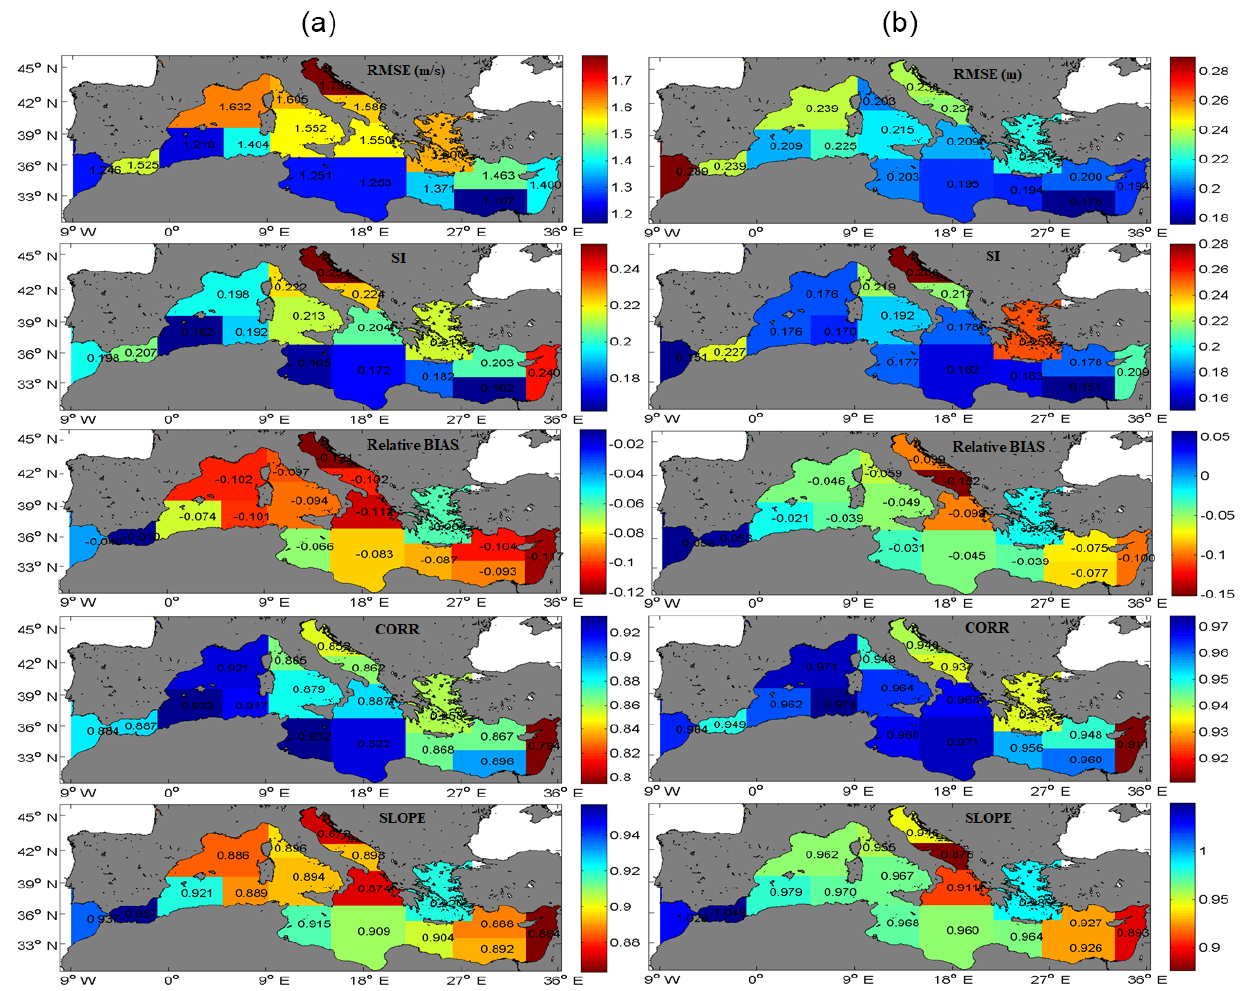
Figure 8. ECMWF U 10 (a) and Med-waves H s (b) evaluation against satellite U 10 (Jason-2) and satellite H s (Jason-2 and SARAL) respec- tively: maps of metric values over the Mediterranean Sea subregions shown in Fig. 3, for a 1-year period